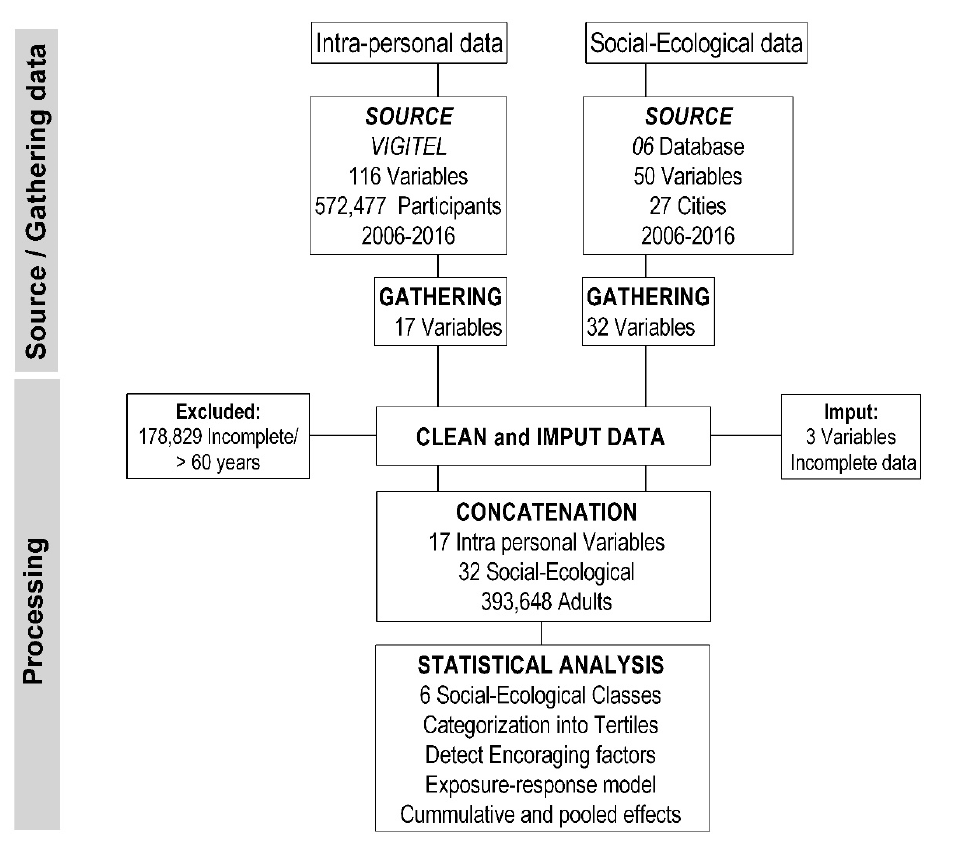
Figure 1. Study flowchart.